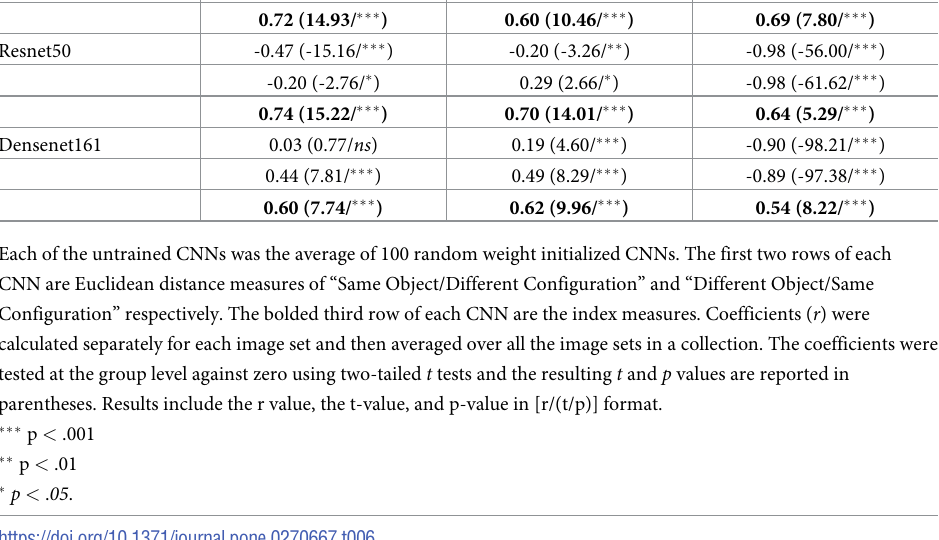
Table 6. Correlation coefficients of Euclidean distance and index measures with the rank order of the sample CNN layers from scene-trained, object-trained and untrained CNNs for the fixed background image collections. CNN Scene Object